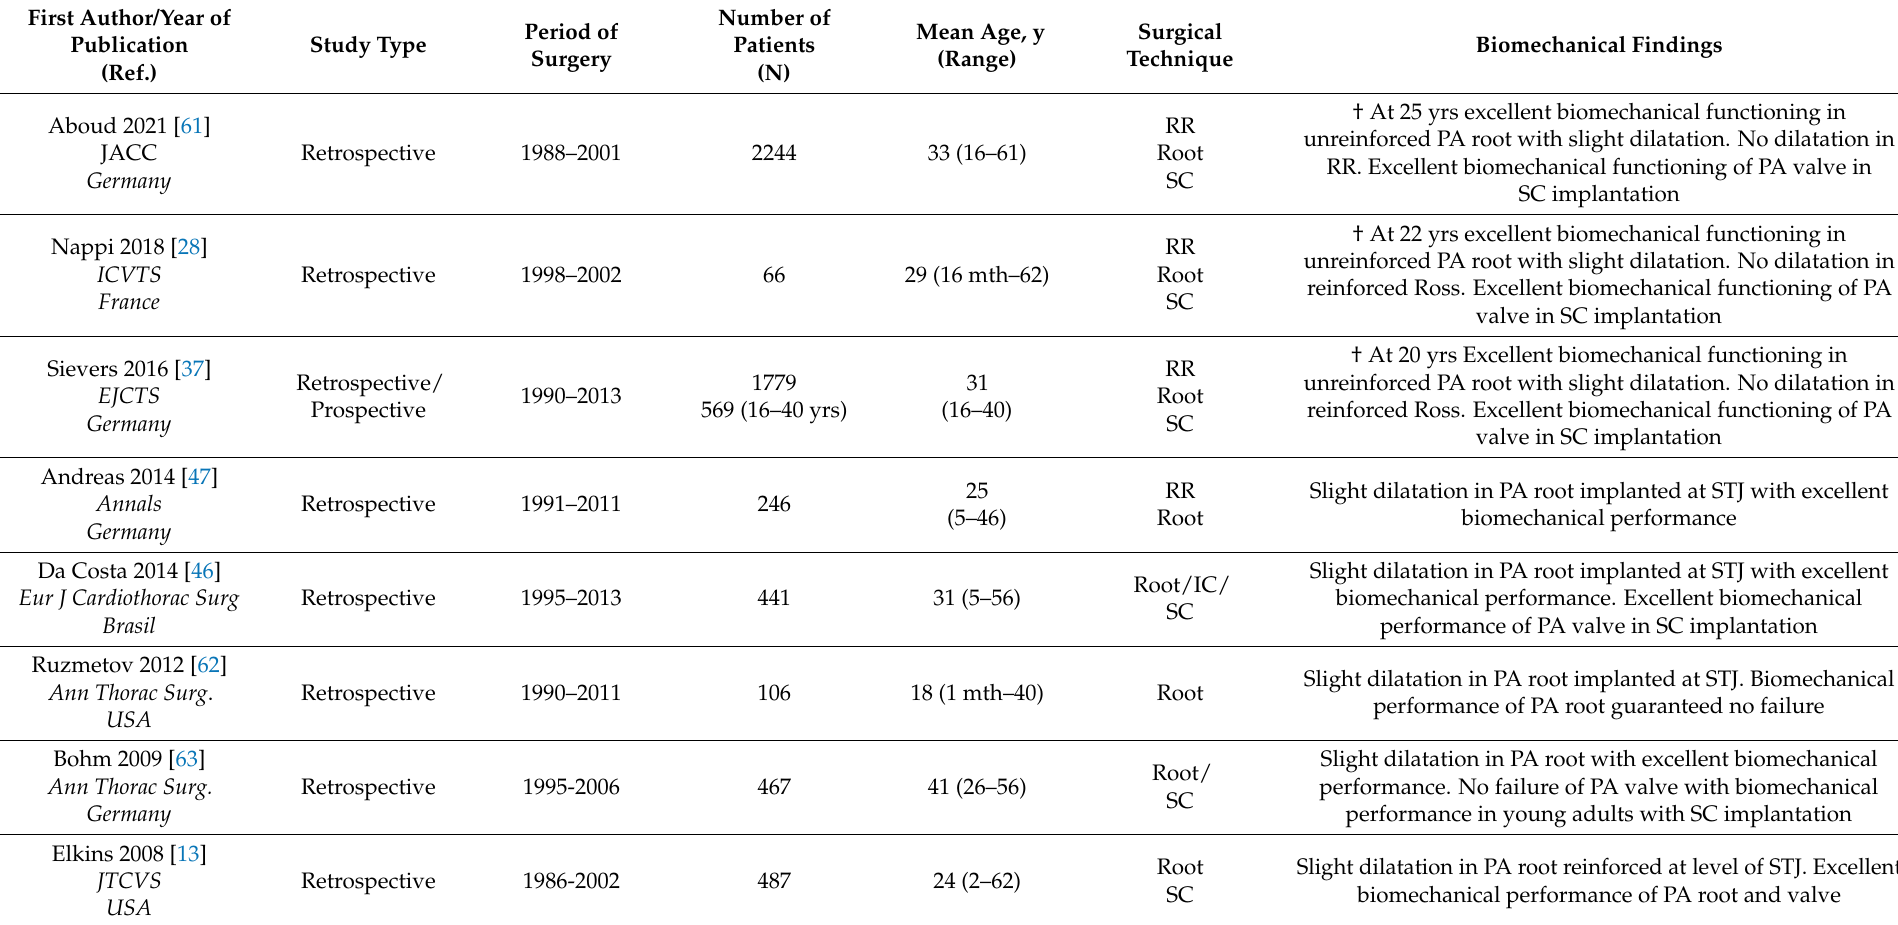
Table 1. Overview of studies obtained by systematic review reporting young adult and pediatric series of Ross